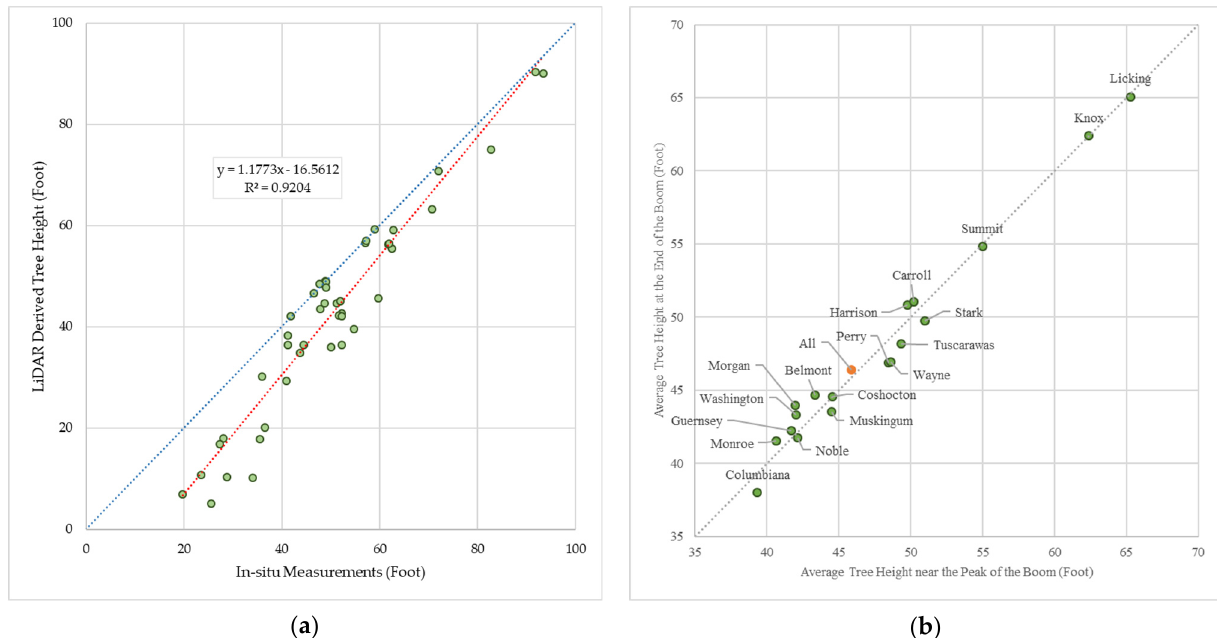
Figure 11. ( a ) The linear regression model developed to correct the tree height from raw canopy height models (CHMs); ( b ) the corrected average tree heights in each county near the peak and at the end of the boom.